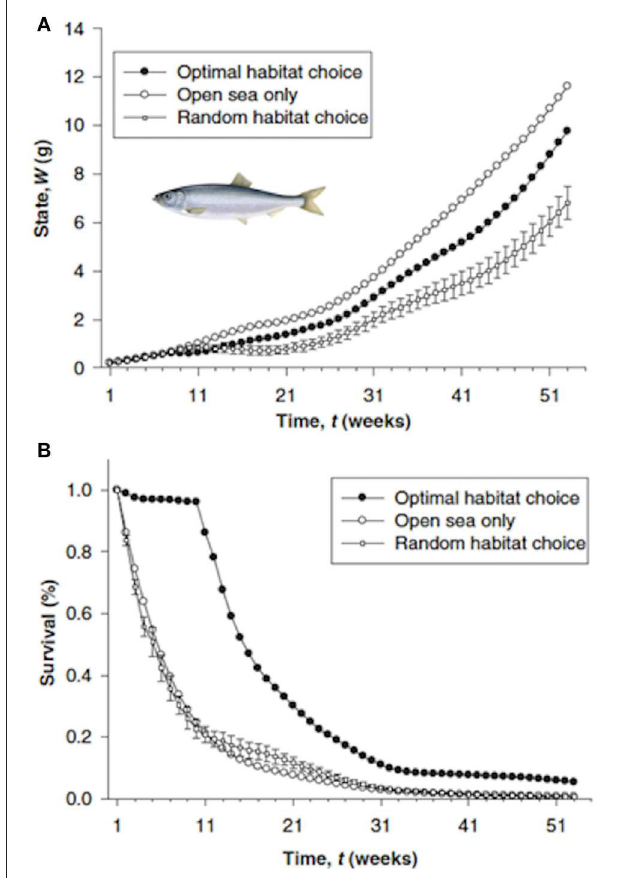
FIGURE 11 | States over time (A) and cumulative survival (B) of three different migration strategies for North Sea herring Clupea harengus ( Maes et al., 2005 ): optimal habitat choice, a forced stay at open sea, and random habitat choice. Errors bars for the random migration represent standard errors of the means of 10 randomized trajectories drawn from a uniform distribution. Time (in weeks) begins on 15 April 1989 (week 1) and ends on 30 March 1990 (week 52). Figure reproduced with permission (Wiley and Sons license 4452010896683) from Maes et al. (2005). Herring figure derived from